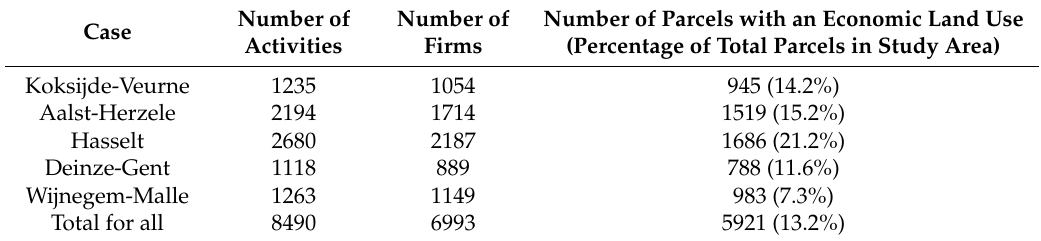
Table 1. Number of activities, firms and parcels per case area from the